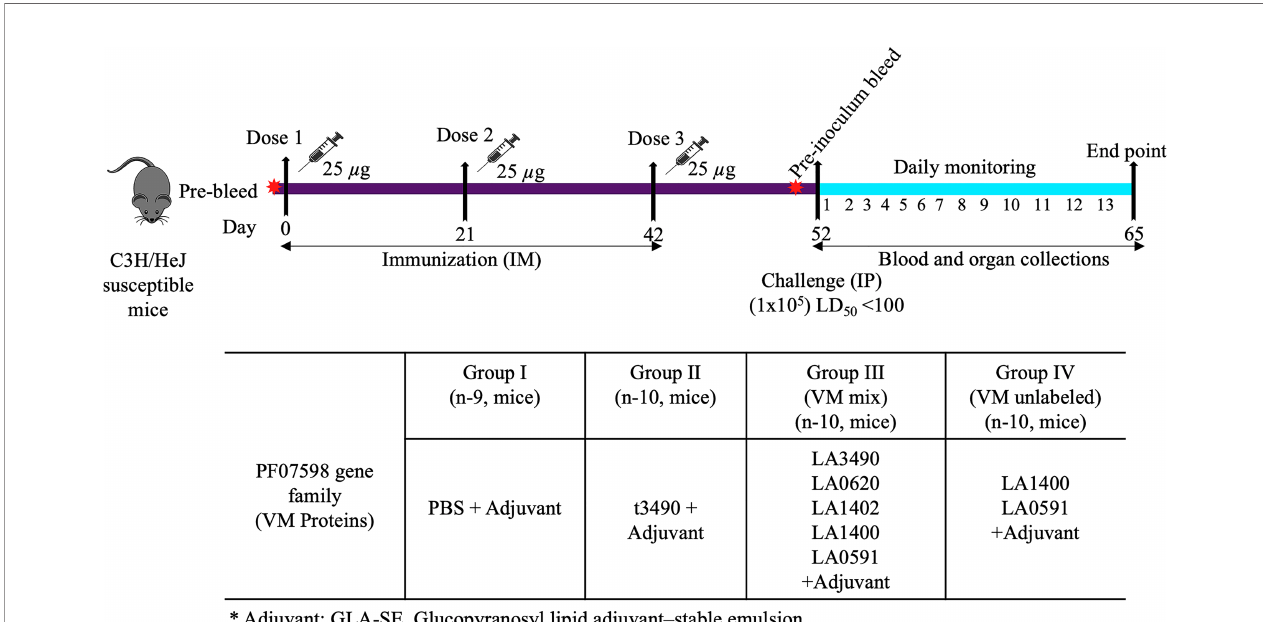
FIGURE 2 | Mouse immunization schedule and sample collection. C3H/HeJ mice were immunized with 25 m g of total antigen along with adjuvant (5 µ g GLA – squalene – oil- in-water emulsion) on days 0, 21 and 42 respectively by intramuscular route. They were pre-bled prior to each immunization and prior to challenge infection and blood was obtained on day of necropsy. Control mice were immunized with PBS buffer plus adjuvant. Following immunization on day 52, mice were infected with live L. interrogans serovar Canicola ( ~ 1x10 5 leptospires, LD 50 <100) by the intraperitoneal route. Blood and organs were collected after subsequent infection.* represent Adjuvant: GLA-SE, Glucopyranosyl lipid adjuvant – stable